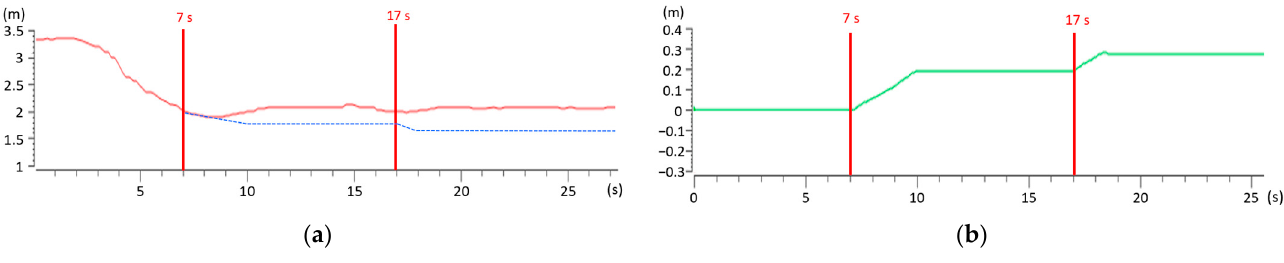
Figure 15. ( a ) Relative distance between the customer and robot and ( b ) corresponding movement of the mobile platform.